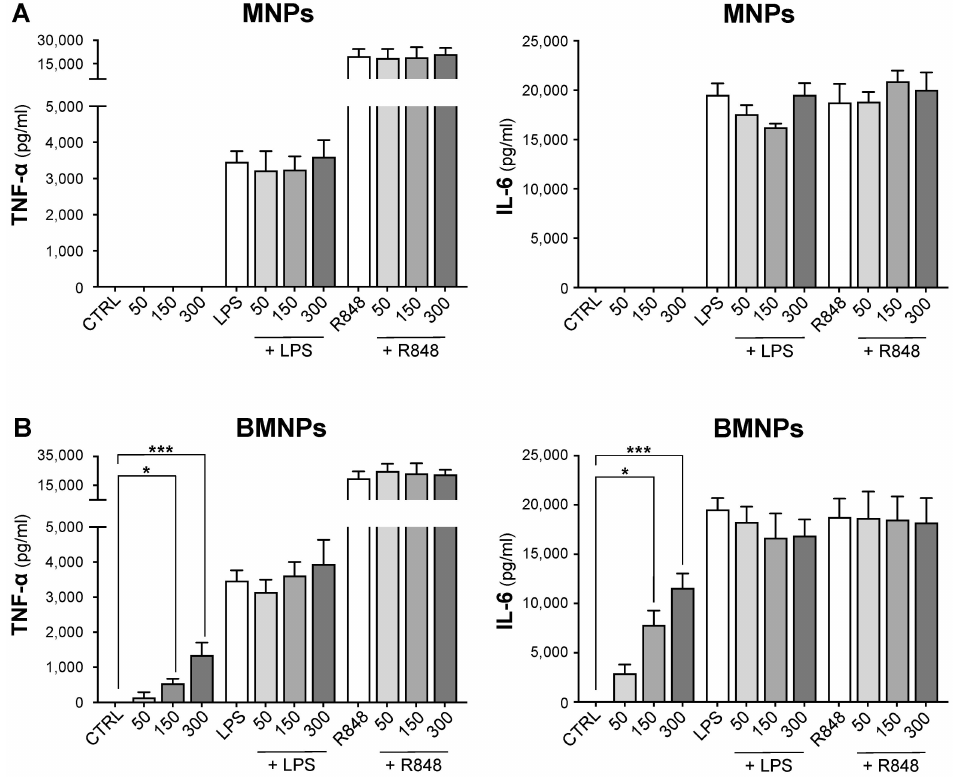
Figure 2. Effects of MNPs and BMNPs on TNF- α and IL-6 release by human monocytes. Monocytes were treated or not (CTRL) for 18 h with the indicated doses ( µ g/mL) of MNPs ( A ) or BMNPs ( B ) as well as with 100 ng/mL LPS or 5 µ M R848 alone or in combination with MNPs or BMNPs. The release of TNF- α and IL-6 in culture supernatants was evaluated by ELISA assay. The results are expressed as the mean value + SEM of four independent experiments. * p < 0.05; *** p < 0.001 by Friedman or Kruskal–Wallis test followed by Dunn’s multiple comparison